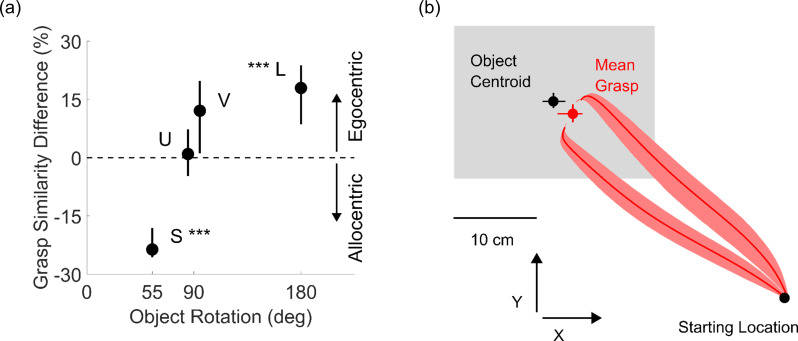
Spatial encoding and bias.(a) Difference in grasp similarity across orientations when grasps were encoded in object-centered (allocentric) vs human-centered (egocentric) coordinates, as a function of magnitude of rotation across the two orientation conditions. (b) Average grasp trajectories viewed in the x-y plane (red curves) from start location towards the objects (always contained within the gray shaded region). The average human grasp (red dot) across conditions is biased toward shorter reaching movements compared to the object centroids (black dot). In both panels data are means, error bars/regions represent 95% bootstrapped confidence intervals. *** p<0.001.